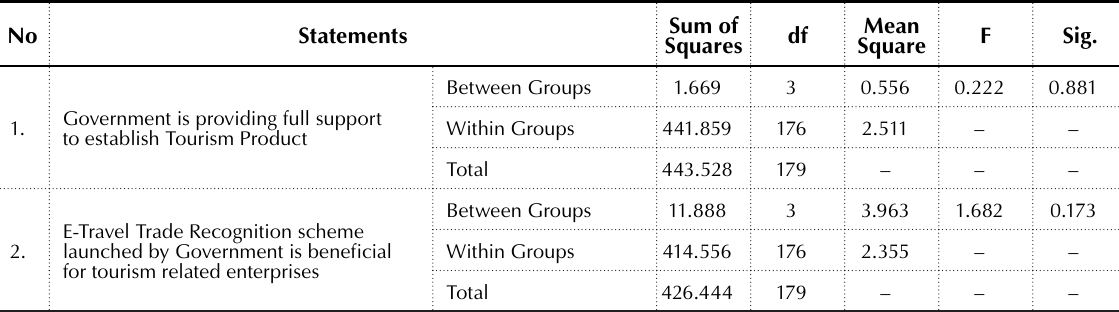
Table 6. ANOVA results for role of government in tourism development in Himachal Pradesh